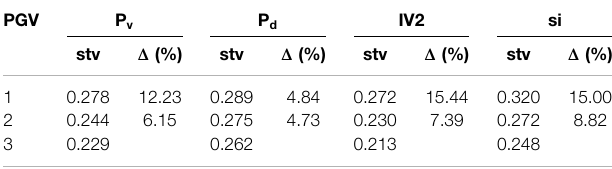
TABLE 7 | Comparison of the standard deviation stv between the leading 4 parameters for estimating PGV.